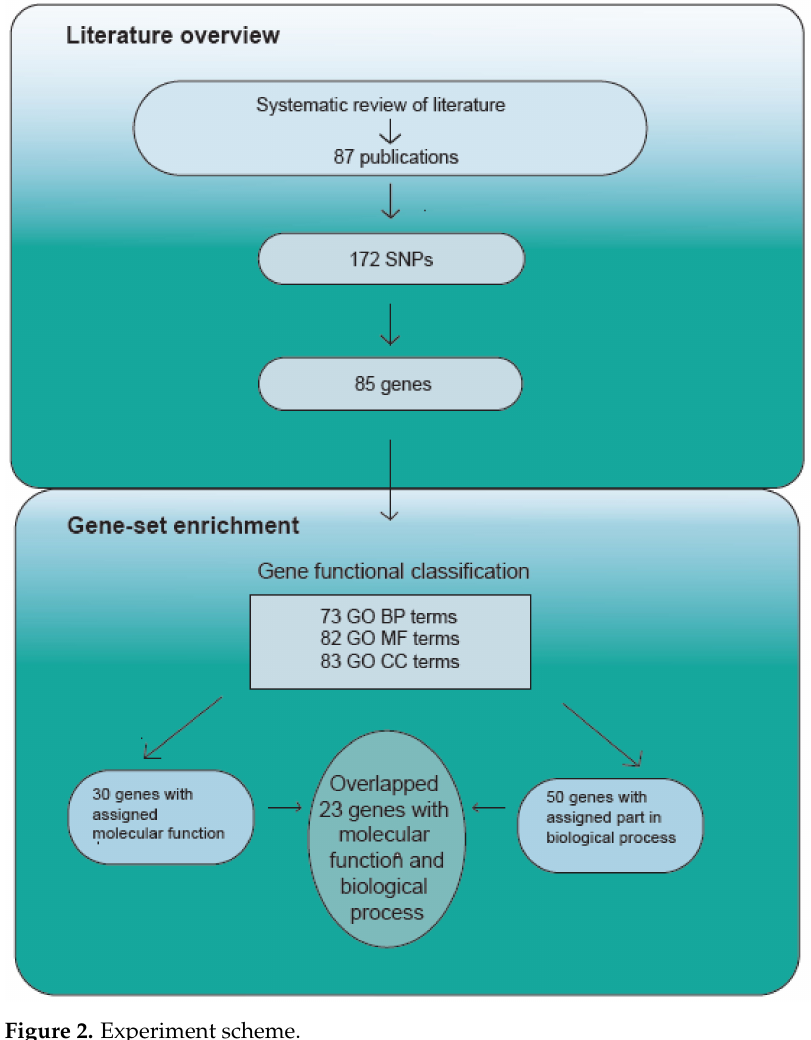
Figure 2. Experiment scheme.